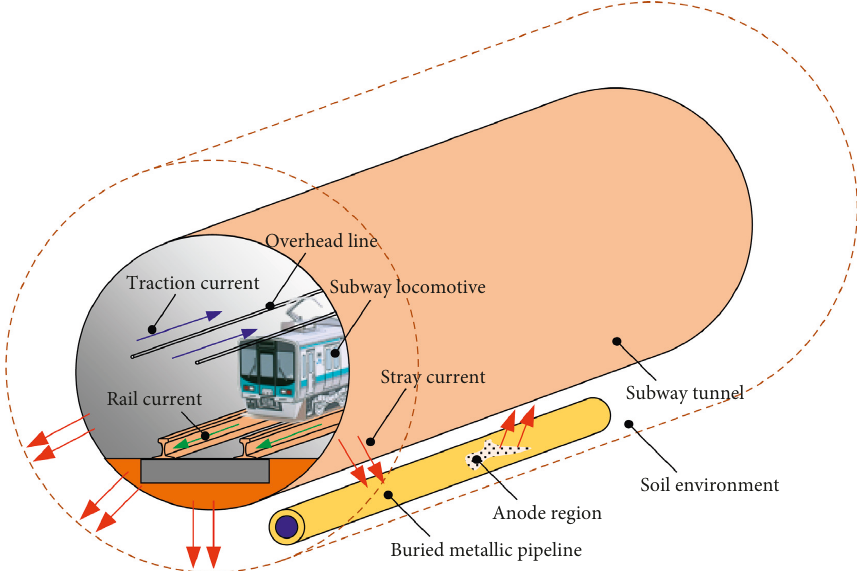
Figure 1: Stray current in the DC mass transit